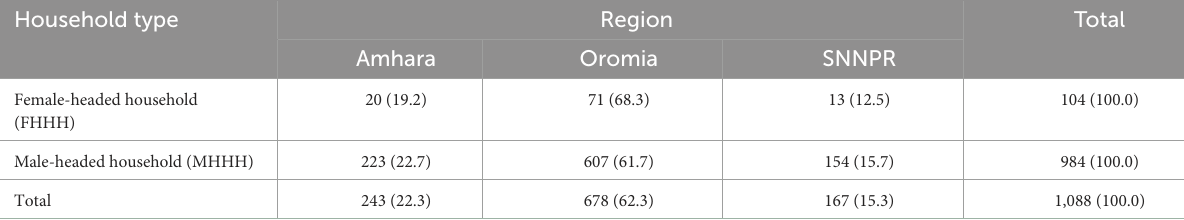
TABLE 1 Distribution of sample farm households by gender of the head across administrative regions. Household type Region Total Amhara